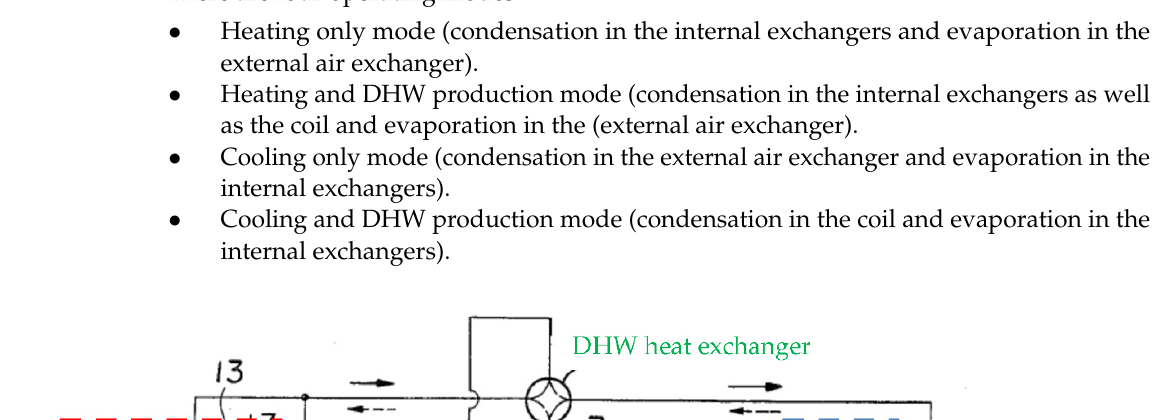
Figure 19. Schematic diagram of the patent of Union Kogyo Kabushiki Kaisha (US5211023). The patent for a simultaneous heating, cooling and dehumidifying device was pre- sented by Jungwirth (US6751972) in 2004 (Figure 20) [64]. The same operating logic as in